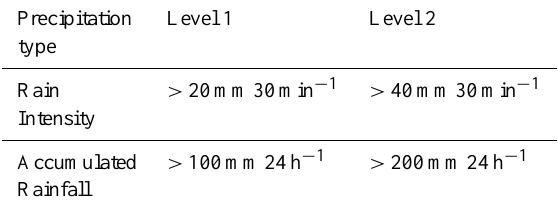
Table 1. Thresholds set by SMC corresponding to the different precipitation warnings and levels (data source: http://www.meteo.